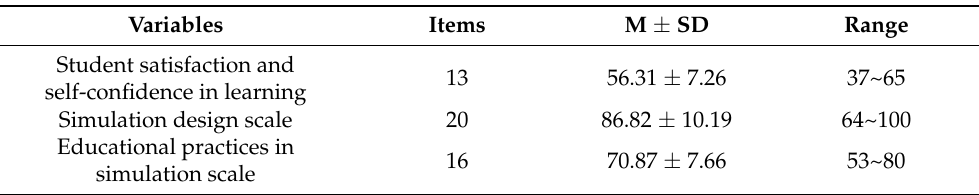
Table 2. Descriptive statistics of variables.